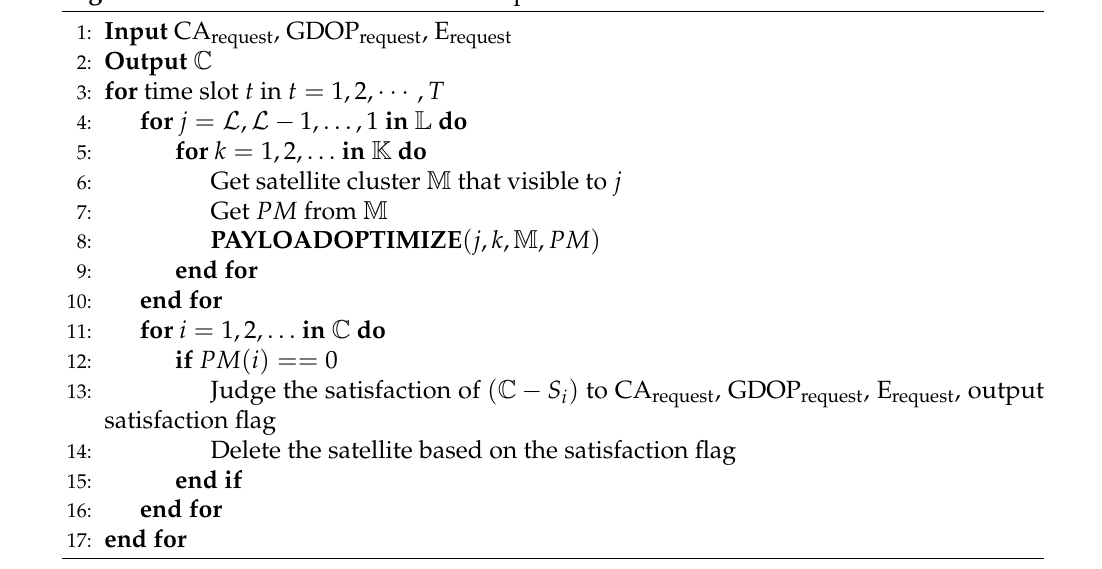
Algorithm 2 Basic constellation reverse optimization.